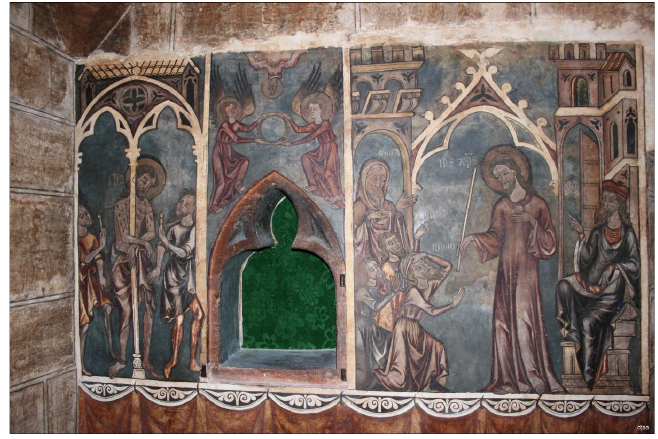
Figure 5. Flagellation, Crown of Thorns and Ecce Homo, ca. 1262, reconditorio or secret chamber, Cathedral of Valencia. © Cathedral of Valencia